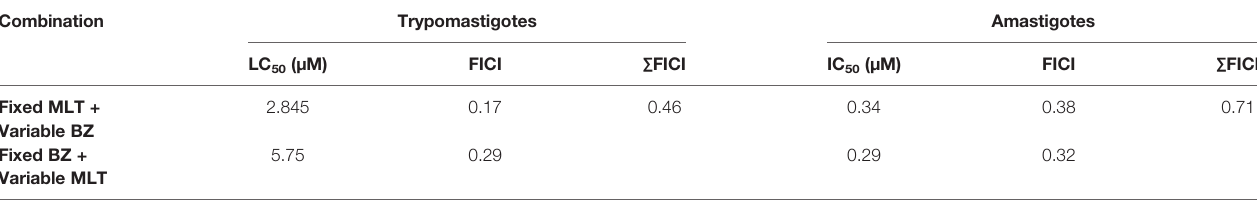
TABLE 4 | In vitro fractional inhibitory concentration index from miltefosine and benznidazole on trypomastigotes and amastigotes stages of Trypanosoma cruzi (VD strain).